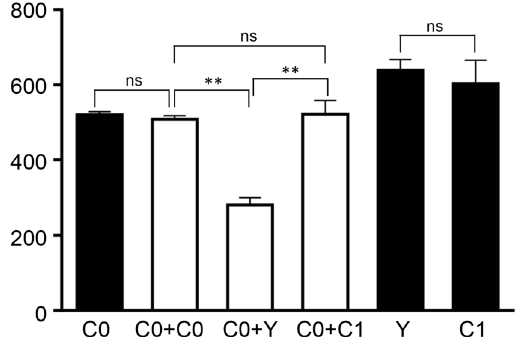
Figure 3. Measurement of mtDNA copy number in primary cells and cybrids. Black columns, primary cells; white columns, cybrid cells. Bars represent standard deviation (SD), n = 3 per group. * P < 0.05, ** P < 0.01 and ns P > 0.05.